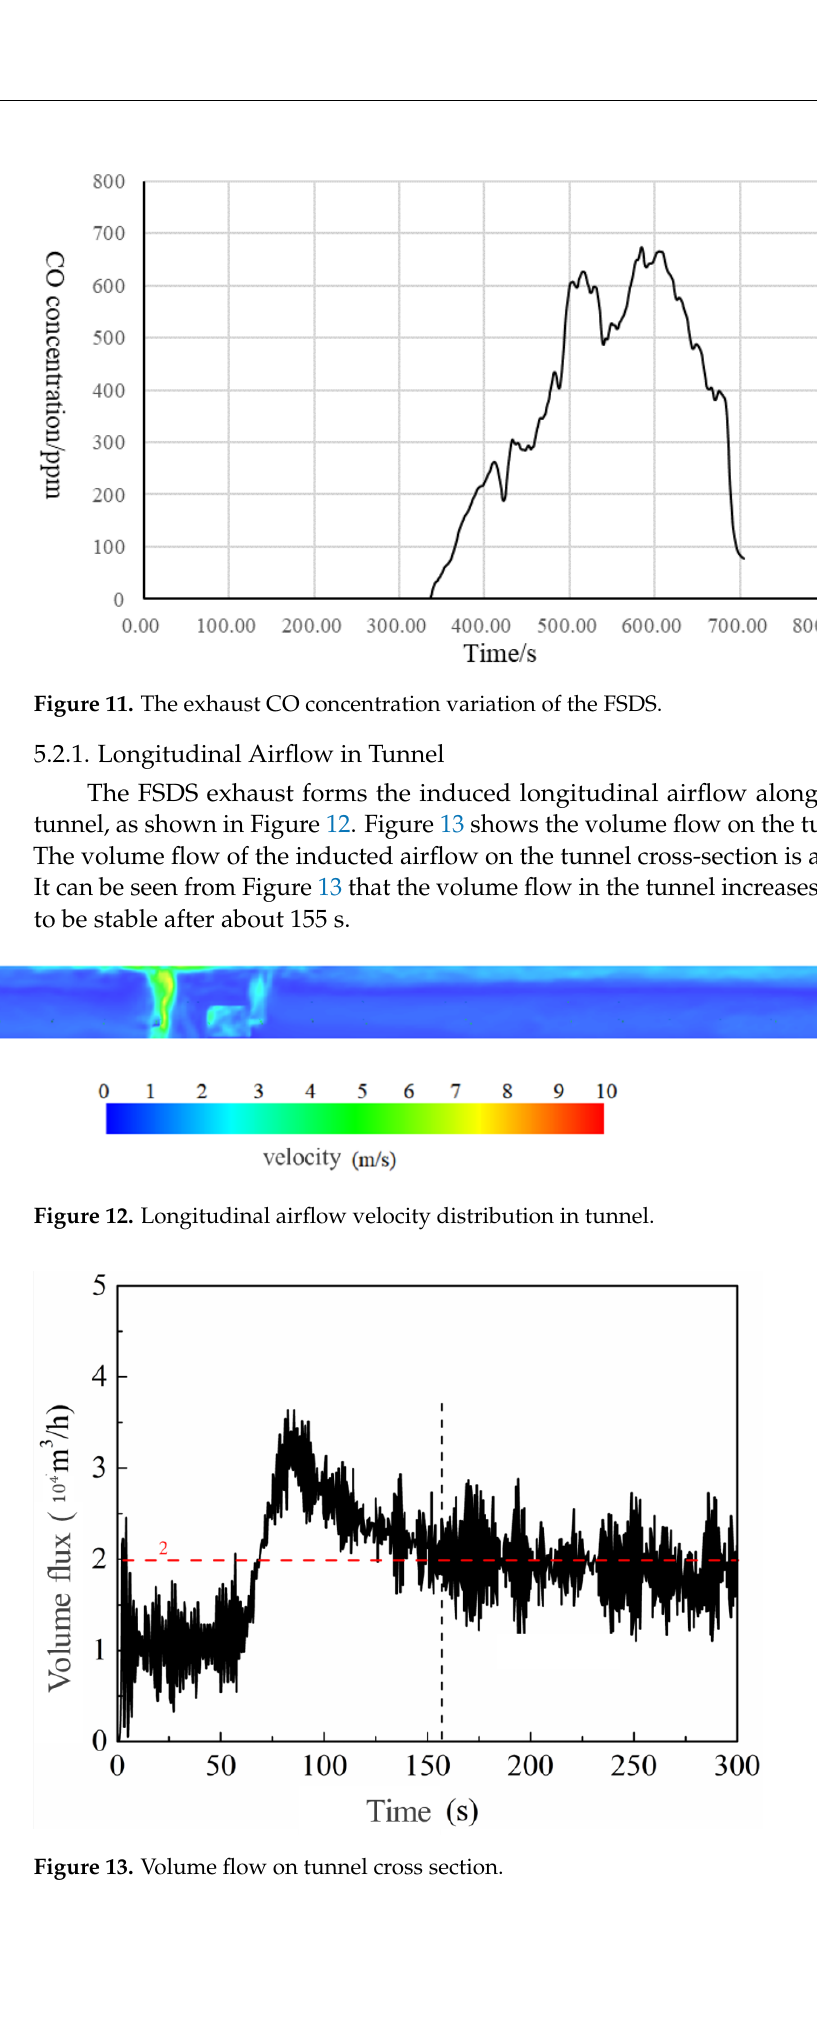
Figure 10. The exhaust temperature variation of the FSDS.